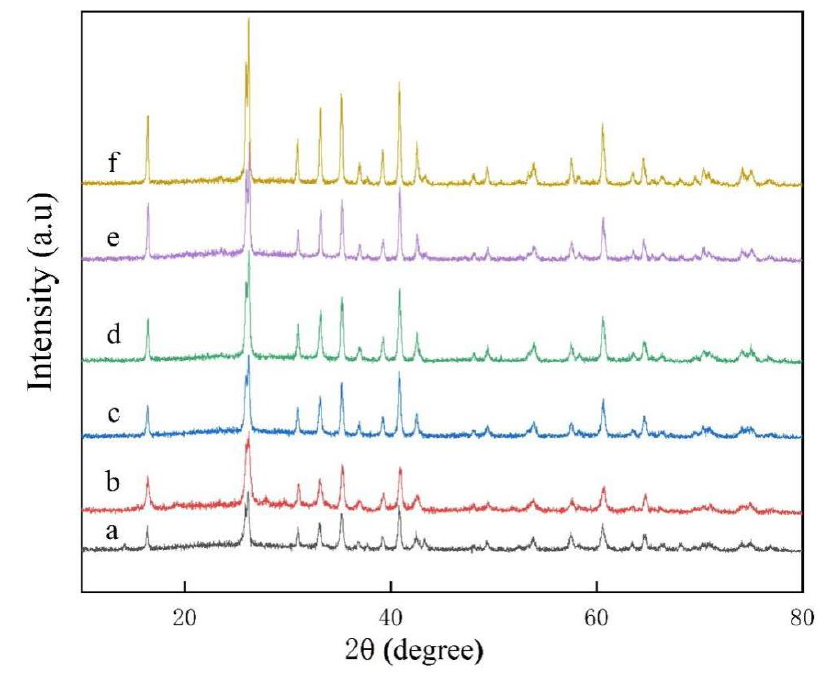
Figure 12. XRD plots of mullite whiskers with different aluminum fluoride contents in 10% sodium sulfate molten salt calcined at 825 °C for 3 h, (a) 0.5% AlF 3 ·3H 2 O, (b) 1% AlF 3 ·3H 2 O, (c) 2% AlF 3 ·3H 2 O, sulfate molten salt calcined at 825 ◦ C for 5 h, (a) 0.5% AlF 3 · 3H 2 O, (b) 1% AlF 3 · 3H 2 O, (c) 2% AlF 3 · 3H 2